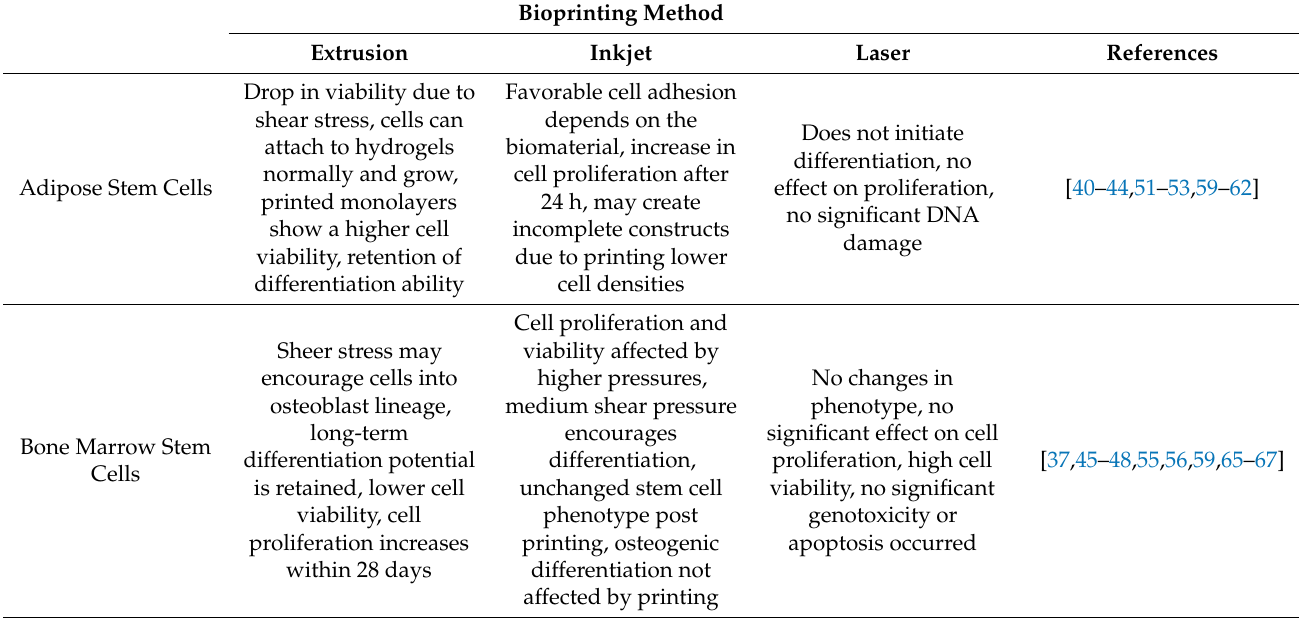
Table 2. Effects of bioprinting techniques on adipose and bone marrow stem